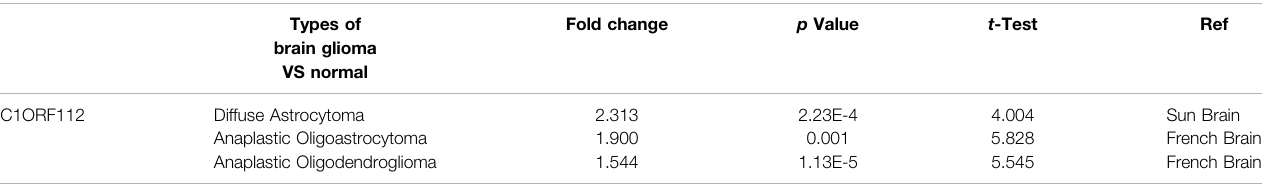
TABLE 1 | Signi fi cant changes of C1ORF112 expression in transcription level between Brain glioma and Normal brain tissues